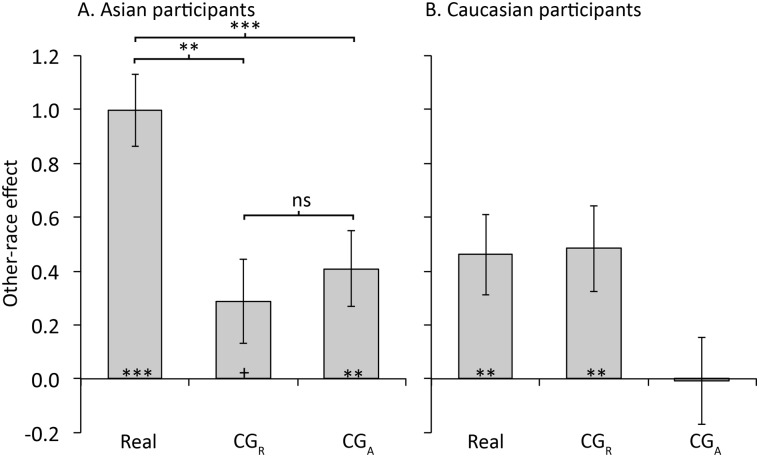
Experiment 1: Other-race effect (d' own-race minus d' other-race) as a function of format for A. Asian participants and B.Caucasian participants.Results of one sample significance tests of the ORE are shown at the base of the bars. Error bars show ± 1 SEM. *** = p < .001,** = p <.01,+= p = .07.